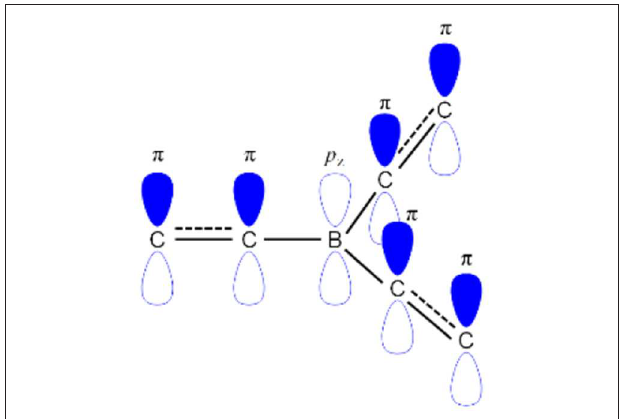
FIGURE 1 | General configuration of p z - π conjugation of B–C atoms in the organic conjugated